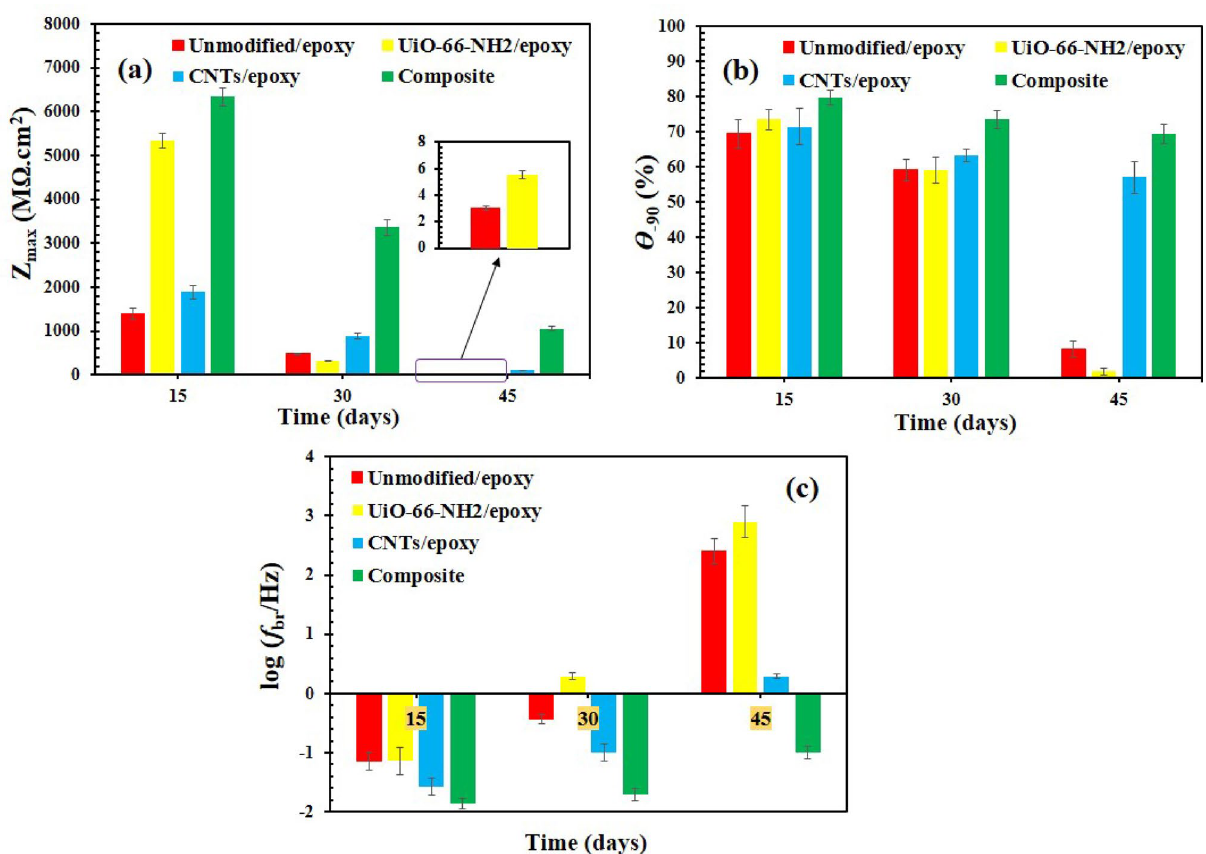
Figure 5. Extracted EIS parameters: ( a ) maximum impedance magnitude ( Z max ), ( b ) the part of Bode phase plot that is in the maximum value (θ -90 ), ( c ) breakpoint frequency ( f br ) at different times: 15, 30, and 45 days (All tests have been repeated three times and the corresponding error bars are illustrated in the figures).